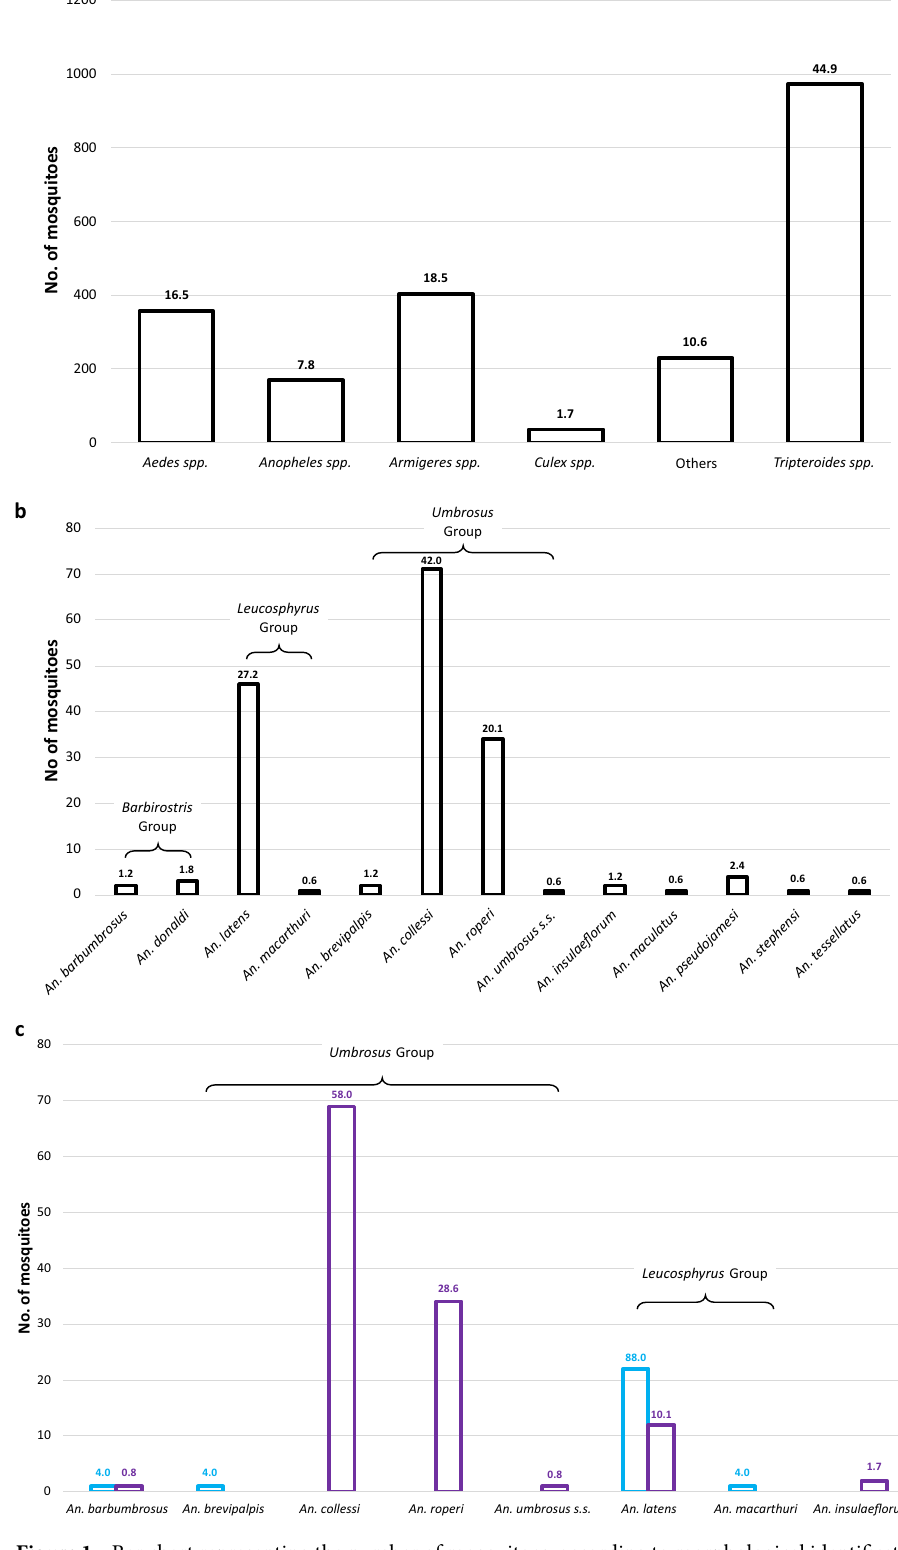
Figure 1. Bar chart representing the number of mosquitoes, according to morphological identification, collected in this study. Percentages of each species are shown above each bar. ( a ) All mosquitoes from all sites. ( b ) Anopheles mosquitoes from all sites. ( c ) Anopheles mosquitoes collected from sites B4 (blue) and SM